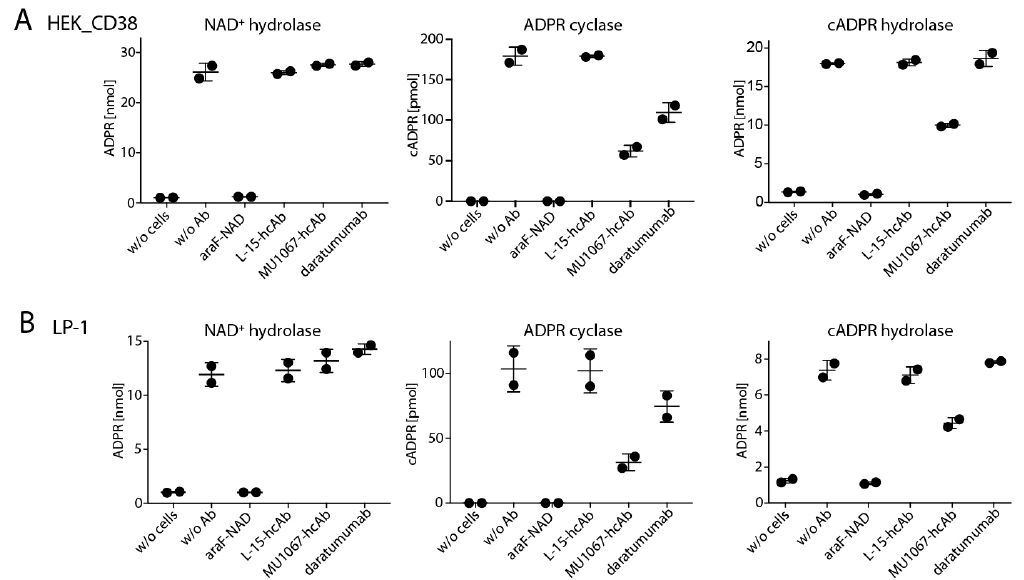
Figure 3. CD38-specific hcAb MU1067 and daratumumab inhibit the ADPR cyclase but not the NAD + hydrolase activity of CD38-expressing LP-1 myeloma cells. HEK cells ( A ) or LP-1 cells ( B ) were pre-incubated for 15 min with the indicated antibodies or araF-NAD at 37 °C, before addition of NAD + or cADPR, and further incubation for 60 min or 180 min at 37 °C, respectively. Nucleotide concentrations were measured by HPLC as in Figure 1. Toxin-specific L-15-hcAb was used as the control. Dots indicate values obtained in two independent experiments.